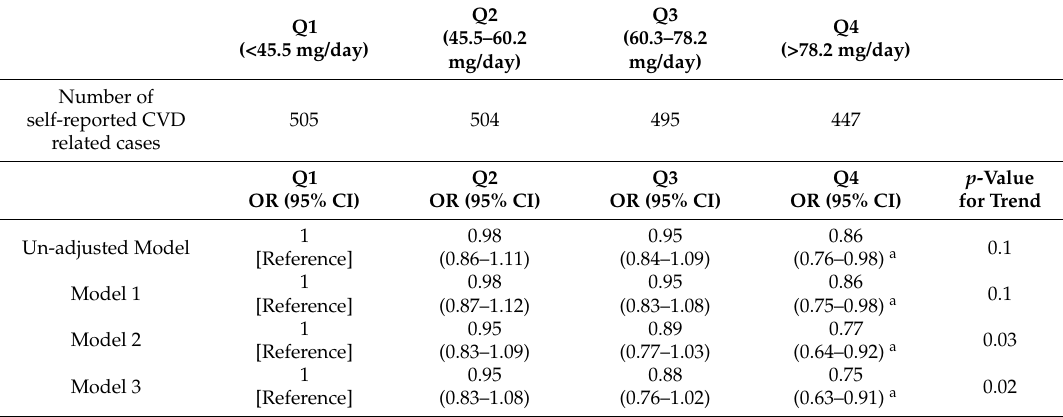
Table 3. Odds of self-reported CVD-related complications by quartile of total nitrate intake in the